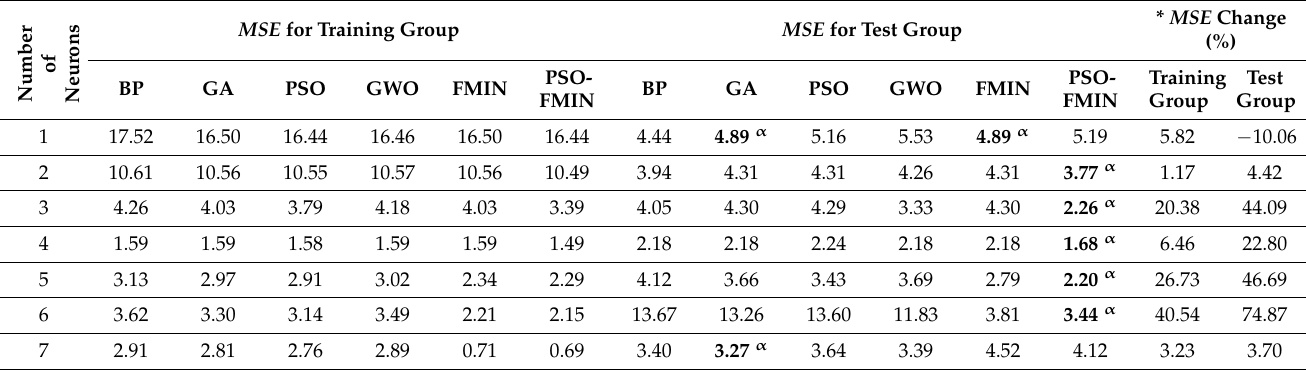
Table 5. Obtained results for the prediction of the a * color coordinate.